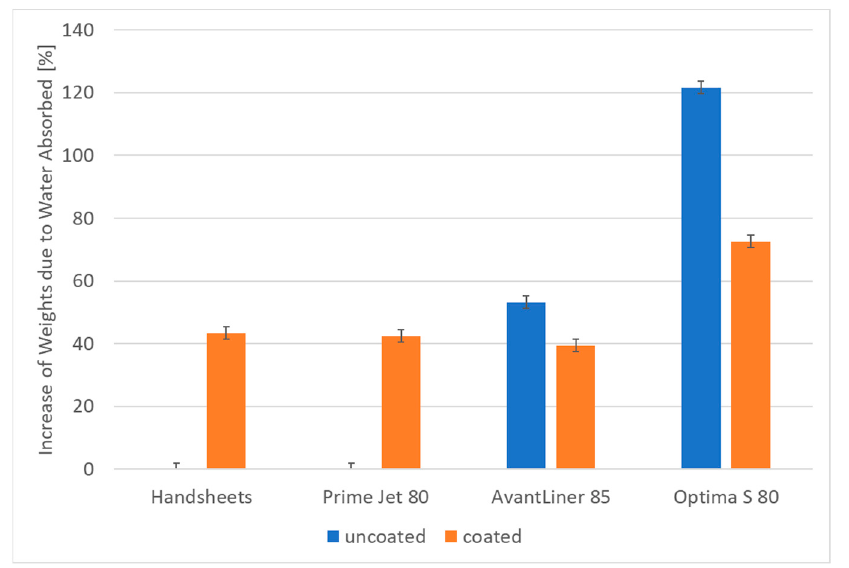
Figure 3. Average increase in weights due to water absorbed (%) (Cobb 20 h) measurements for tested papers.